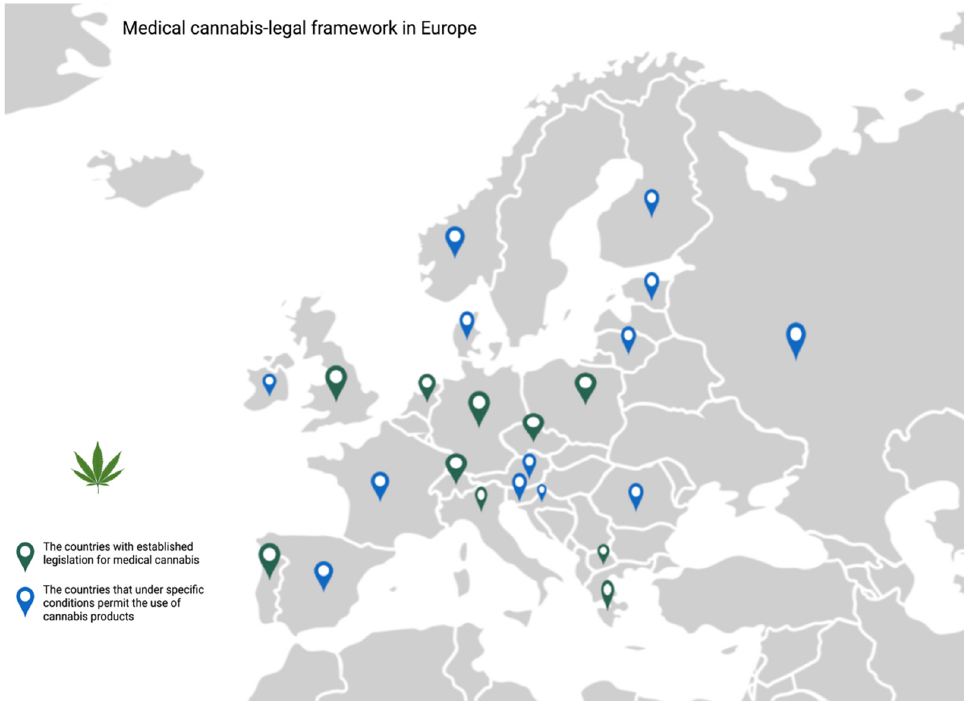
Figure 3. Legal framework for using medical cannabis in European countries.